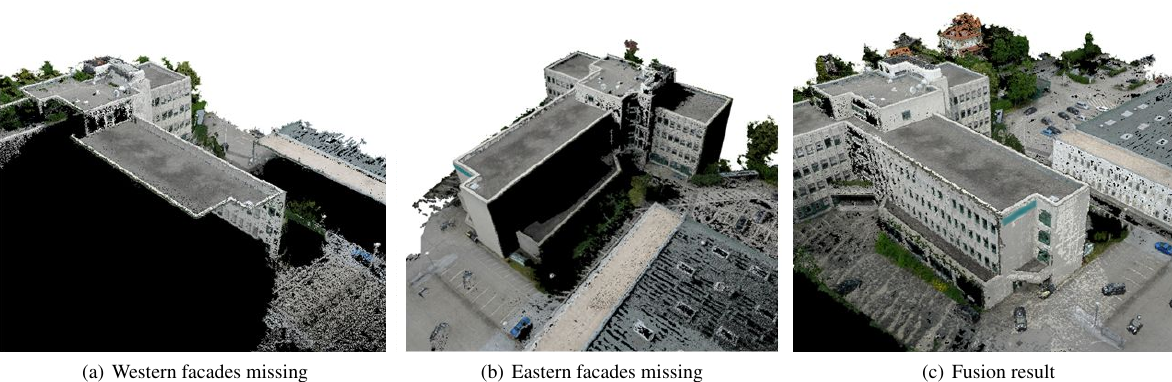
Figure 1: Typical results for the automatic fusion of two partial reconstructions, based on MAV imagery. Best viewed in color. ground into account and therefore even benefits from complex